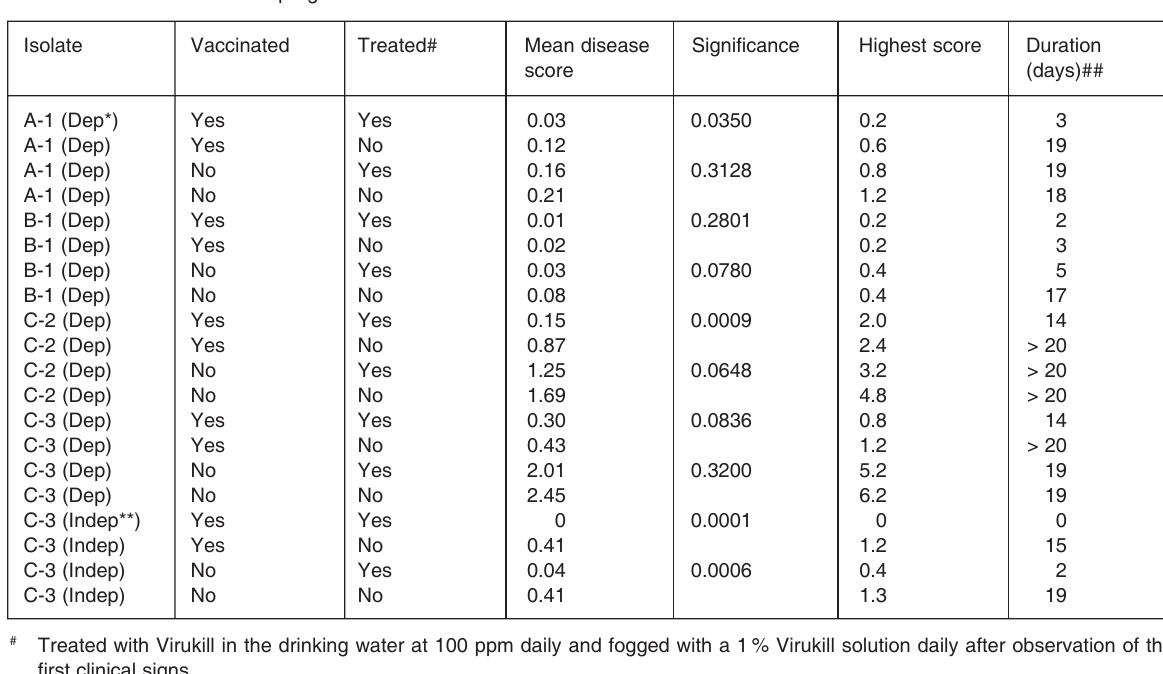
TABLE 1 Summary of the disease scores and profiles obtained when vaccinated and unvaccinated chickens challenged with the different serovars of NAD-dependent and NAD-independent isolates of H. paragallinarum and either treated with a con- tinuous disinfection program or not treated Isolate Vaccinated